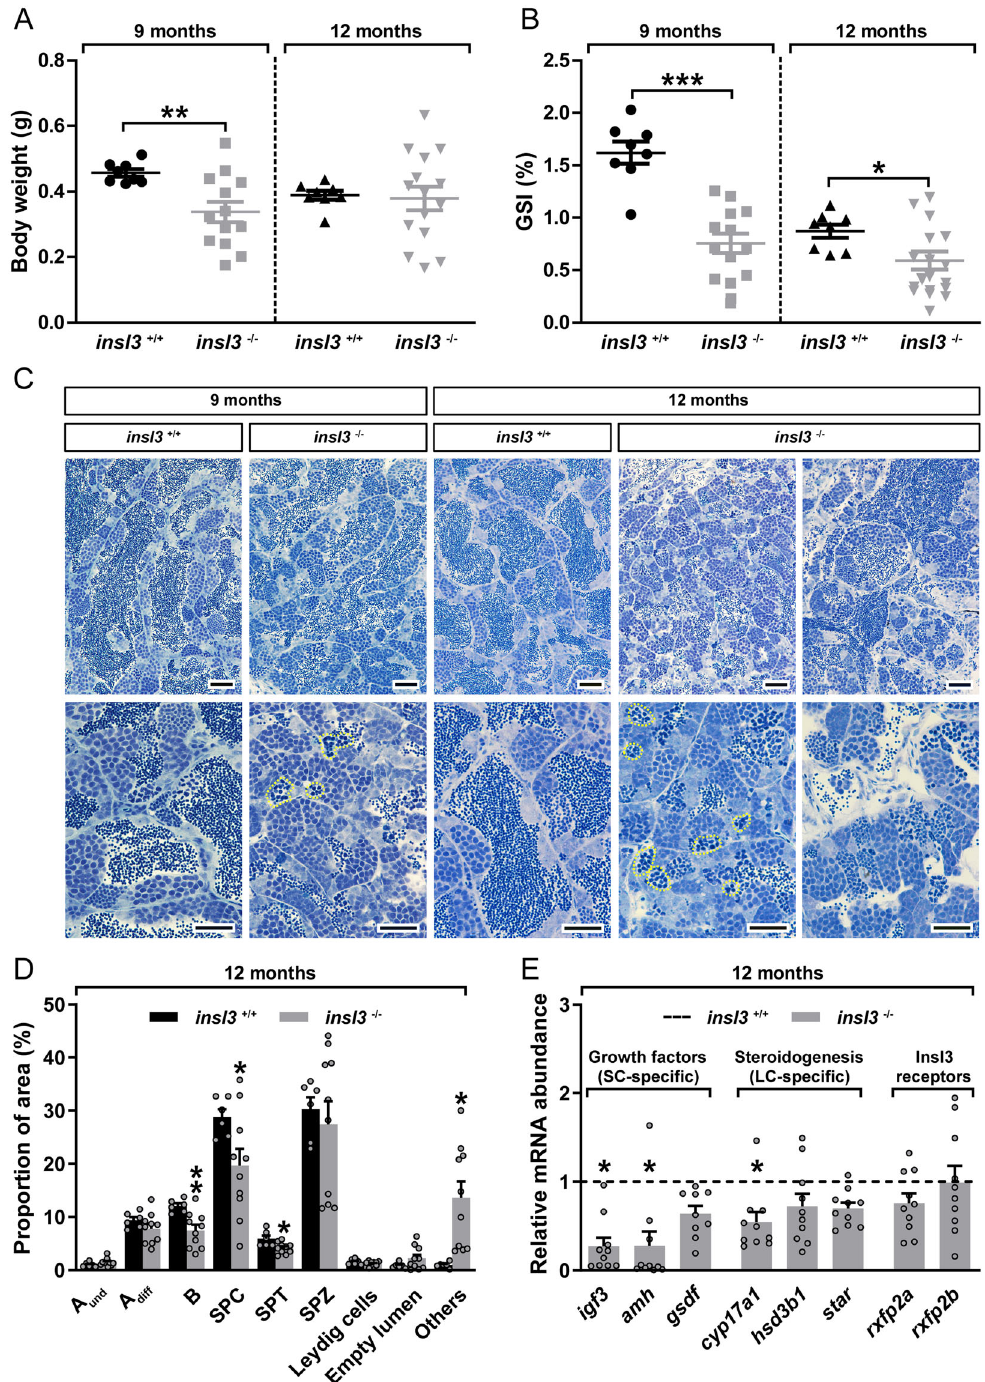
Fig. 2 Genetic ablation of the insl3 gene results in increased germ cell apoptosis in the zebra fi sh testis. A – C Body weight ( A ), gonado-somatic indices (GSI; B ) and testicular morphology ( C ) of wild-type ( insl3 + / + ) and insl3 knockout ( insl3 − / − ) males 9 and 12 months post-fertilization. Data are mean ± SEM ( insl3 + / + and insl3 − / − , 9 months: N = 8 and 13; insl3 + / + and insl3 − / − , 12 months: N = 8 and 15; p < 0.05; ** p < 0.01; *** p < 0.001). In C , yellow dashed lines indicate representative apoptotic germ cell cysts. Scale bars, 25 µ m. D , E Quantitative analysis of spermatogenesis ( D ) and transcript levels of growth factors, steroidogenesis-related and Insl3 receptors ( E ) in 12 months-old insl3 + / + and insl3 − / − adult testis tissue. Data are mean ± SEM ( insl3 + / + and insl3 − / − : N = 6 and 10; * p < 0.05; ** p < 0.01) and, in E , expressed as relative to the wild-type group (which is set at 1; dashed line). A und , type A undifferentiated spermatogonia; A diff , type A differentiating spermatogonia; B, type B spermatogonia; SPC, spermatocytes; SPT, spermatids; SPZ, spermatozoa; Others, including (i) empty spaces lined by Sertoli and/or germ cells that are not part of the lumen, (ii) Sertoli cell only areas, and (iii) apoptotic cells (see Supplementary Fig. 2 for further details); SC, Sertoli cell; LC, Leydig